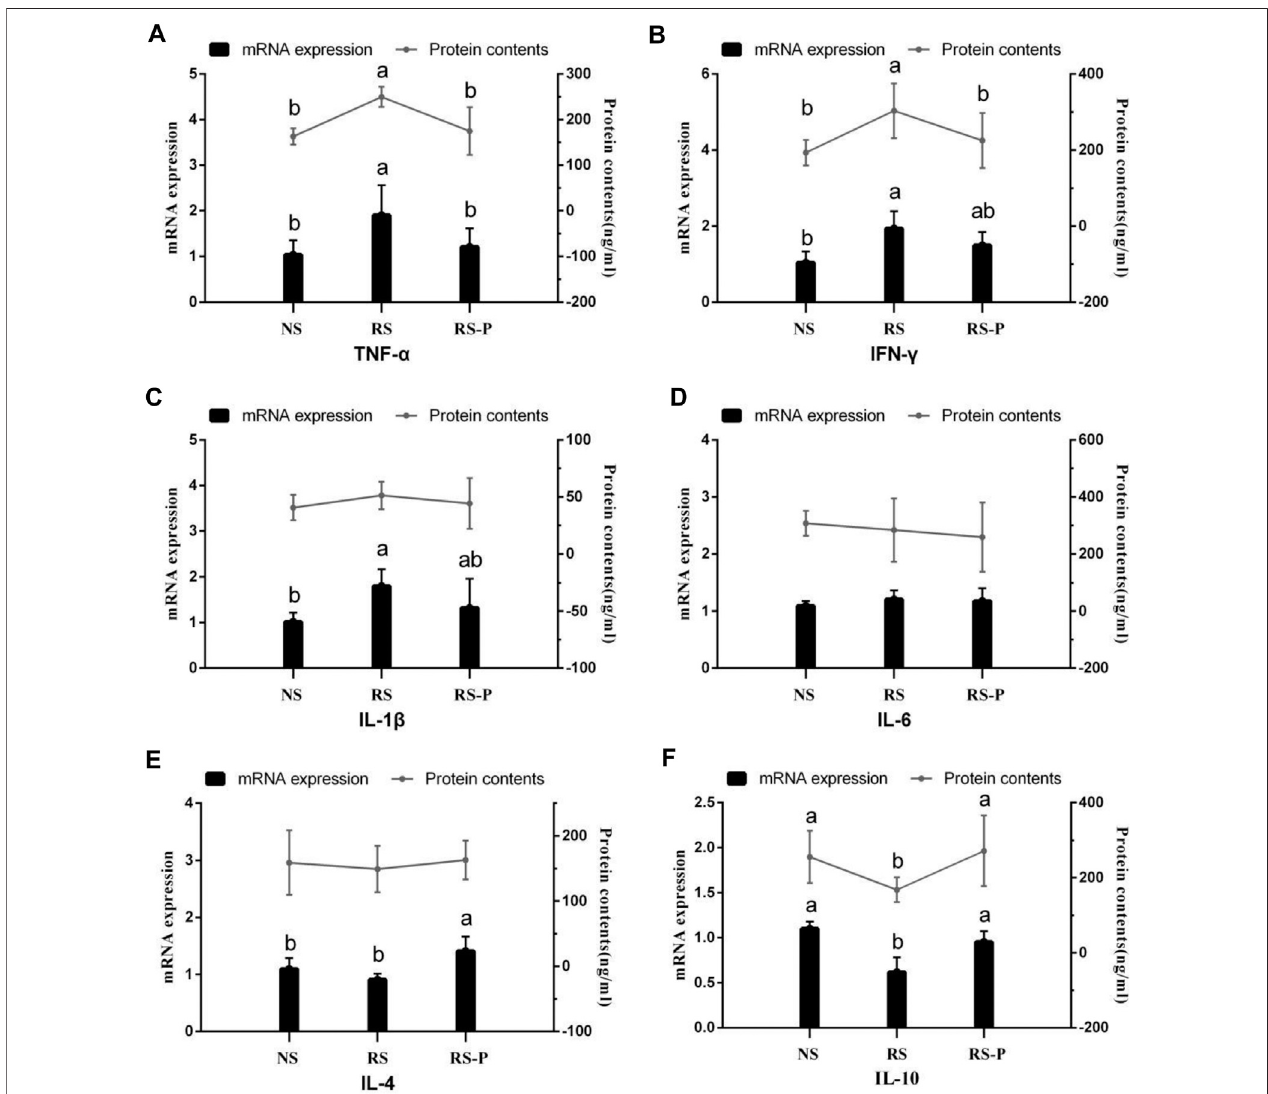
FIGURE 13 | Protein contents and mRNA expression levels of in fl ammatory factors in the ileum. Data are presented with the means ± standard deviation ( n (cid:2) 6). Barswithdifferentlettersaresigni fi cantlydifferentonthebasisofDuncan ’ smultiplerangetest( P < 0.05). (A) – (F) :mRNAexpressionlevelsandproteincontentsofTNF- α ; IFN- γ ; IL-1 β ; IL-6; IL-4; IL-10, respectively. TNF- α , tumor necrosis factor-alpha; INF- γ ,